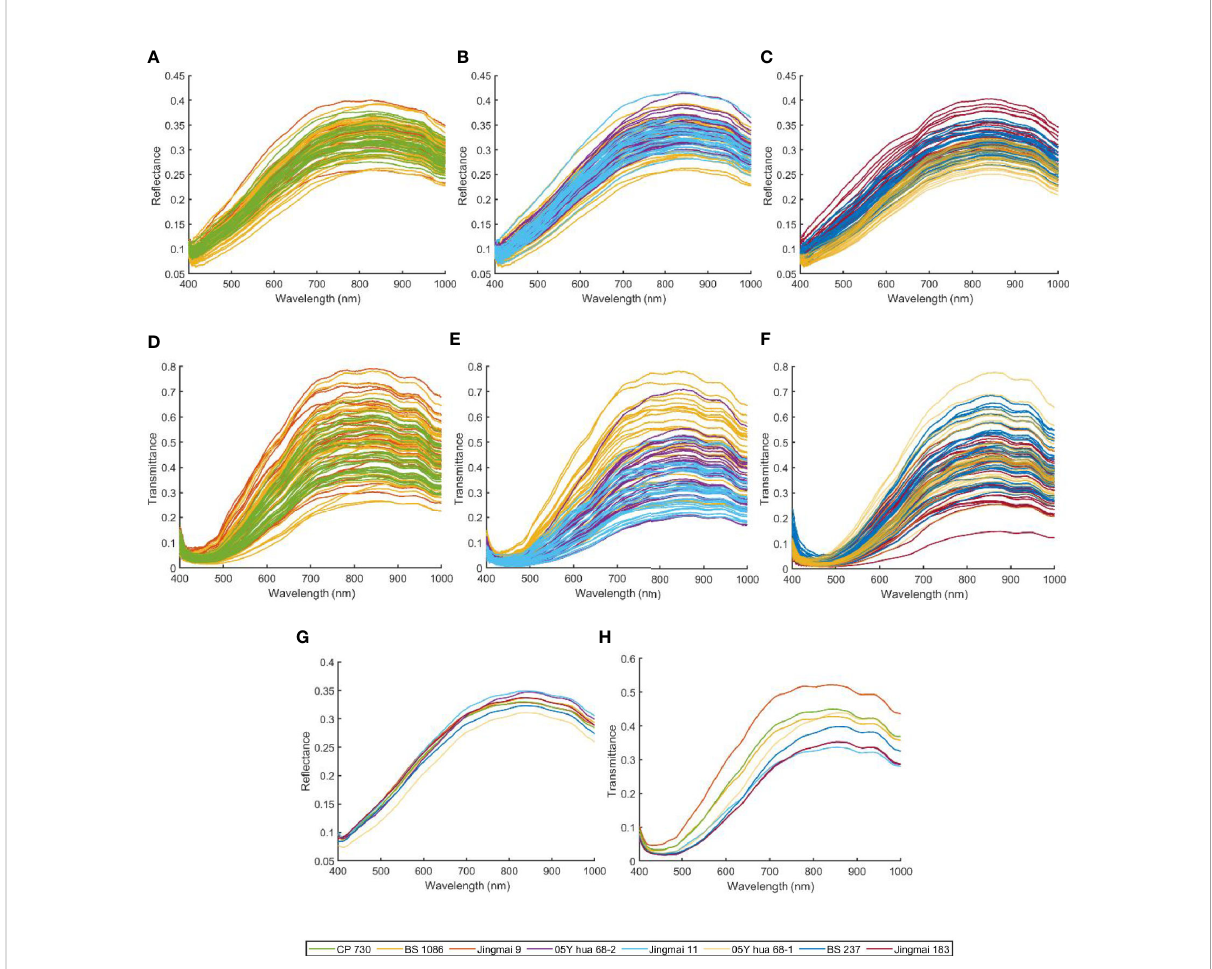
FIGURE 4 Spectral curve of hybrids and their individual parental seeds: raw re fl ectance spectra of (A) Jingmai 9, BS 1086, CP730, (B) Jingmai 11, BS 1086, 05Y hua 68-2, and (C) Jingmai 183, BS 237, 05Y hua 68-1; raw transmittance spectra of (D) Jingmai 9, BS 1086, CP730, (E) Jingmai 11, BS 1086, 05Y hua 68-2, and (F) Jingmai 183, BS 237, 05Y hua 68-1; (G) the average re fl ectance spectra of each wheat variety; (H) the average transmittance spectra of each wheat